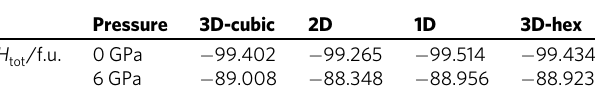
/f.u. (in eV) of tot